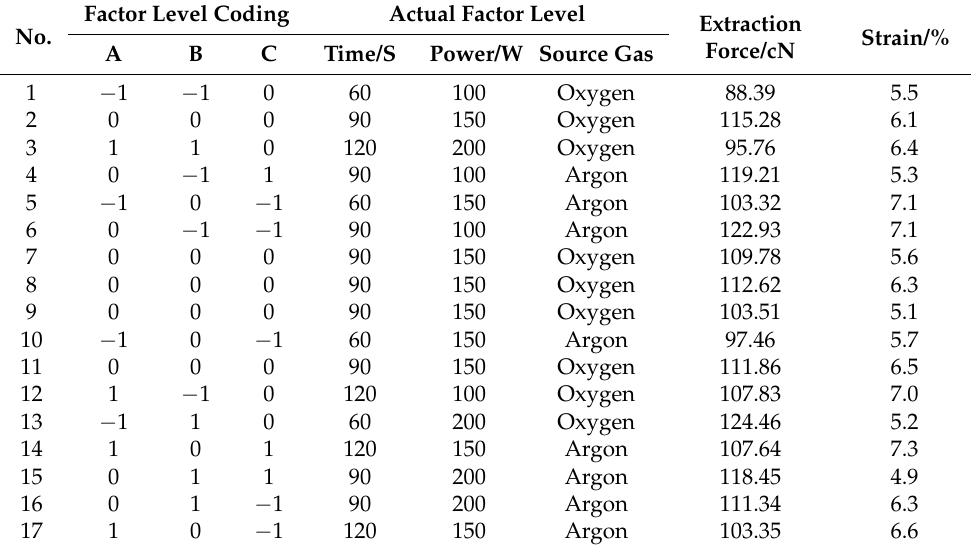
Table 2. Experimental design and